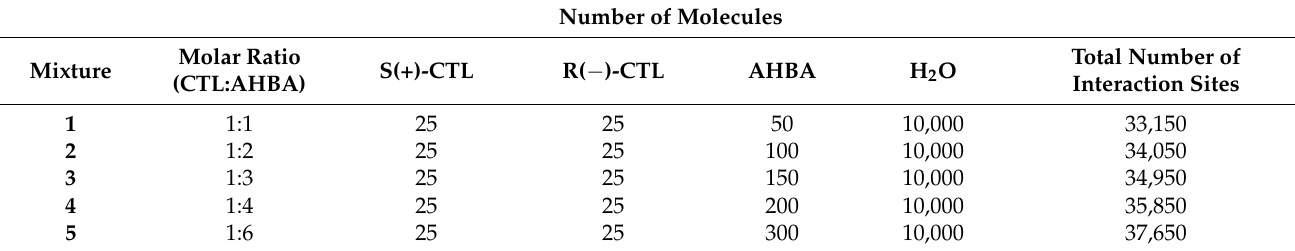
Table 1. Composition of the studied pre-polymerization mixtures. Number of